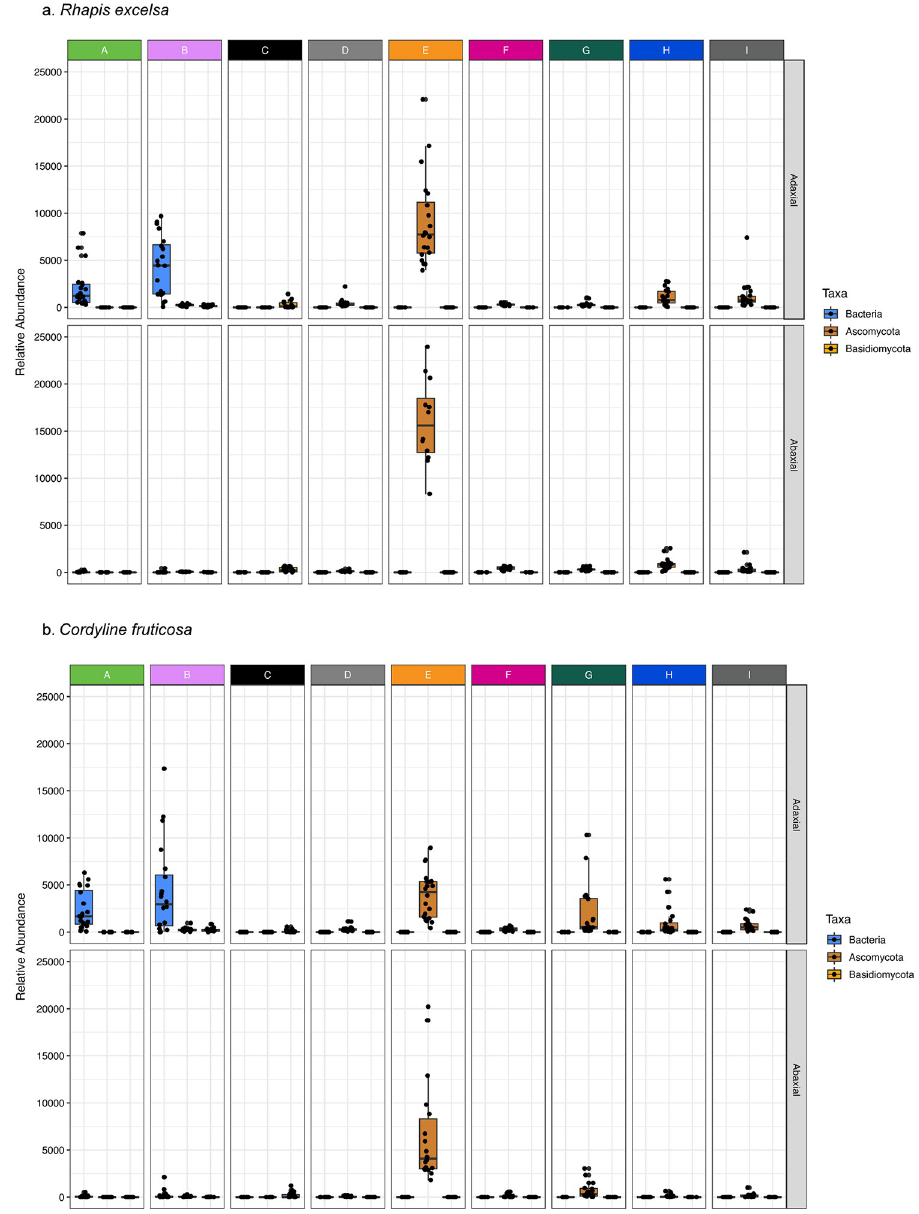
Fig 4. Relative abundance of each microbial co-occurrence cluster. Comparison of the normalised read counts among the nine microbial clusters (A to I) revealed that the orange cluster, composed of leaf blotch fungi, dominates the leaf surfaces of (a) R . excelsa and (b) C . fruticosa . The leaf blotch fungi were twice as abundant on the abaxial surface compared to the adaxial counterpart. The dense clusters A and B network observed in Fig 3 suggest an interaction among the group of leaf, soil, and radio-tolerant bacteria on the adaxial surface. These results further detail the reduction in microbial diversity on the abaxial surface.